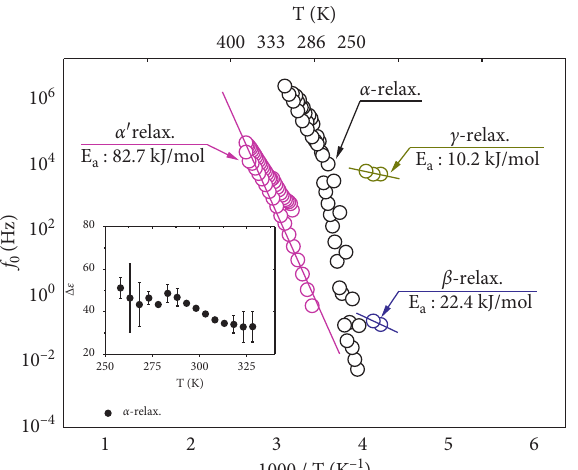
Figure 8: The relaxation rate versus reciprocal temperature for NBR. The activation energy for the relaxation process is the slope of the solid line. The overlapped circle symbols of α and α ’ just denote a repeated analysis. The inset shows the variation in the relaxation